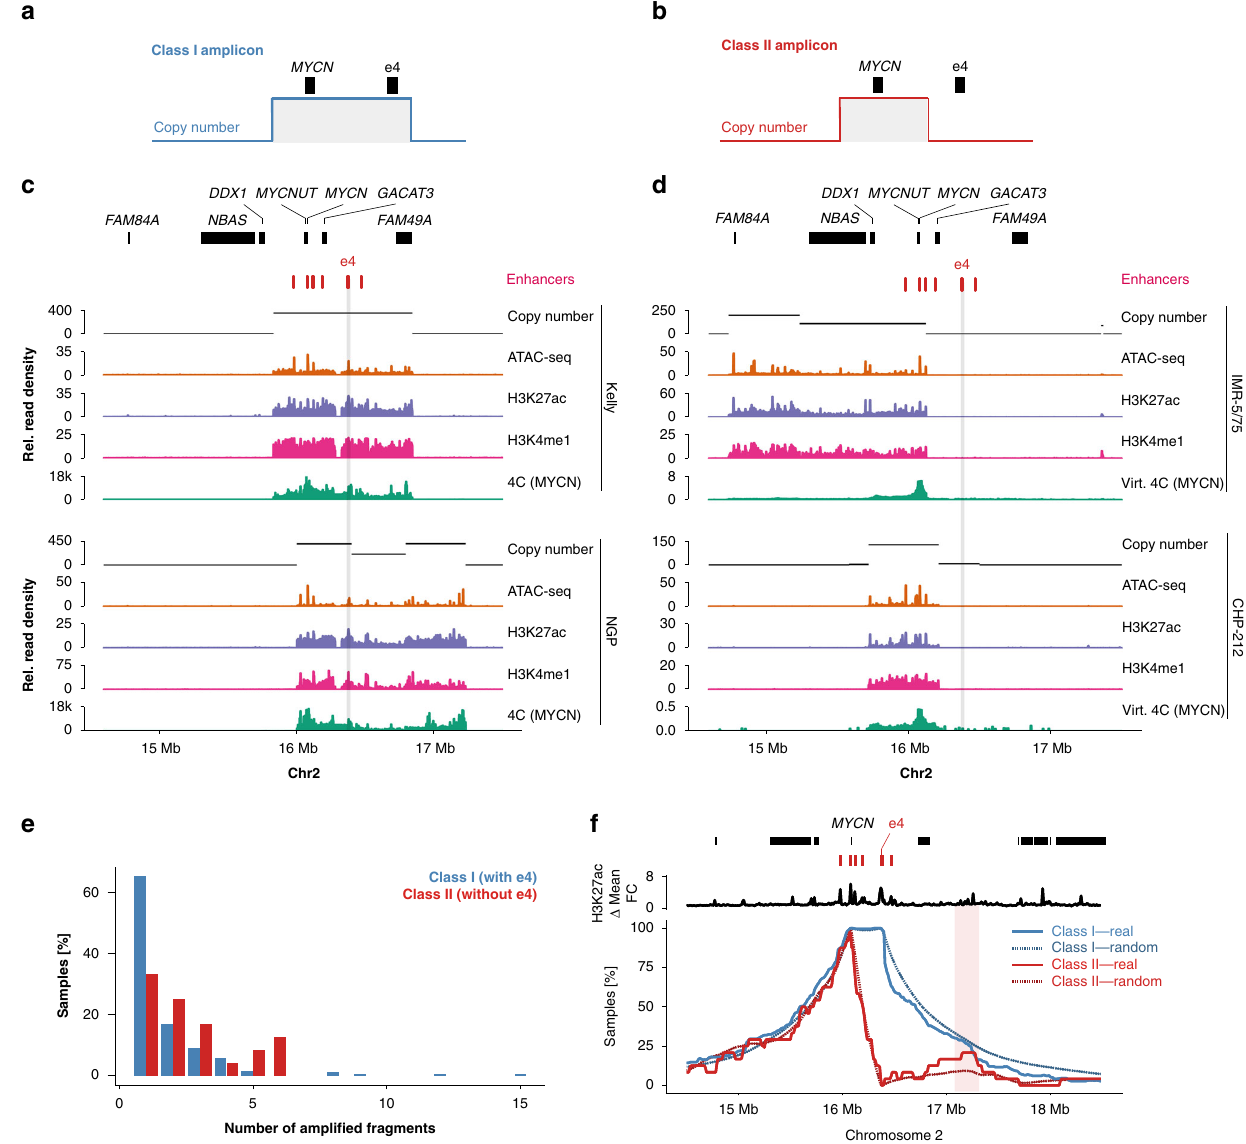
Fig. 3 Two classes of MYCN amplicons can be identi fi ed in neuroblastoma. Schematic representation of class I ( a ) and class II ( b ) MYCN amplicons. c Copy-number pro fi le (black), ATAC-seq (orange), H3K27ac ChIP-seq (purple), H3K4me1 ChIP-seq (pink), and 4C ( MYCN promoter as the viewpoint; green) for two neuroblastoma cell lines with class I amplicons, co-amplifying the e4. d Copy-number pro fi le (black), ATAC-seq (orange), H3K27ac ChIP- seq (purple), H3K4me1 ChIP-seq (pink), and virtual 4C ( MYCN locus as the viewpoint; green) for two neuroblastoma cell lines class II amplicons, not co- amplifying e4. e Number of non-contiguous ampli fi ed fragments in class I samples ( N = 216) vs. class II samples ( N = 24). f Amplicon boundary frequency relative to gene and enhancer positions in class I vs. class II amplicons compared to random amplicon boundary frequencies. Source data are provided as a Source Data fi